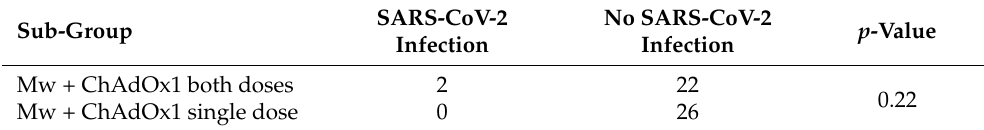
Table 2. Sub-group analysis within Mw + ChAdOx1 group.